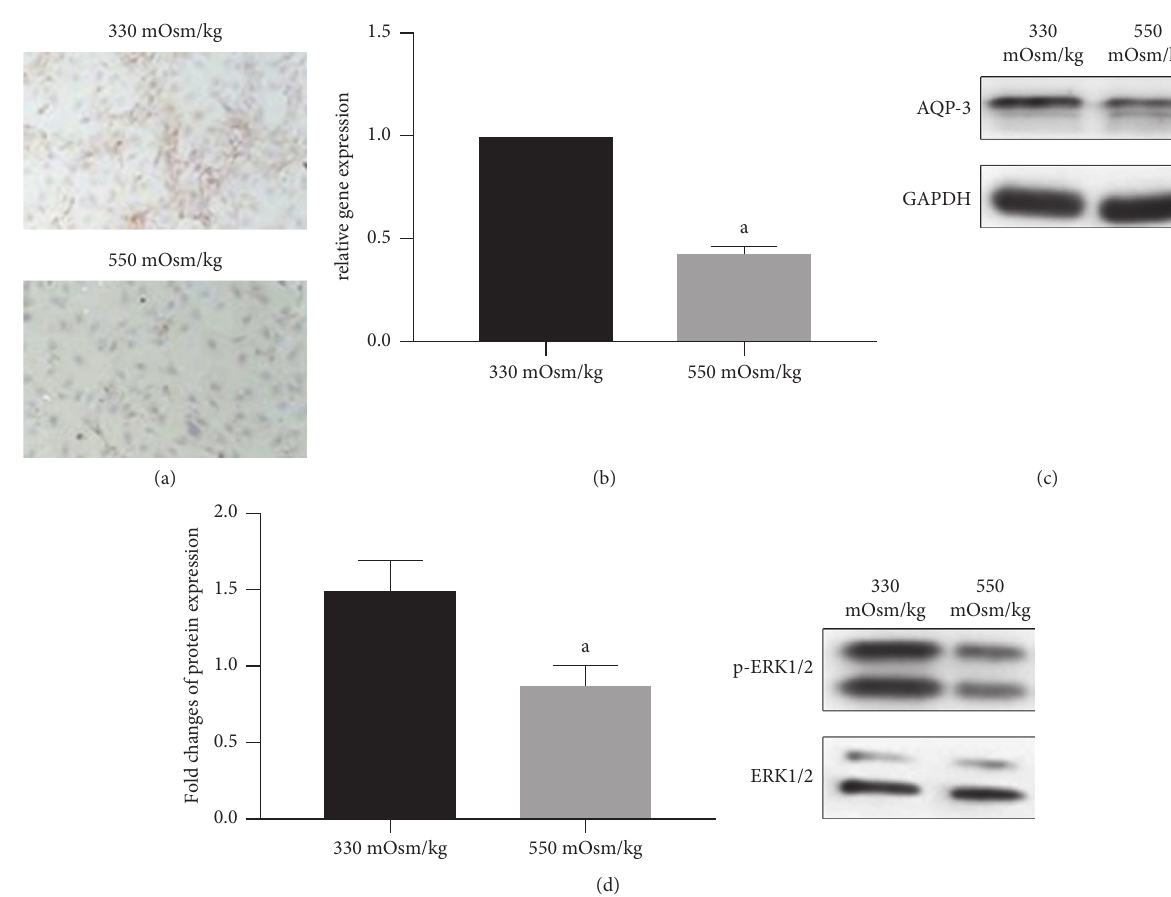
Figure 3: Hyperosmolarity decreased AQP-3 expression and inhibited activation of ERK1/2 signaling in NP cells. (a) Immunocytochemical detection of AQP-3 expression of NP cells under different osmotic pressures (330 mOsm/kg and 550mOsm/kg). (b, c) Real-time PCR and western blotting analysis of AQP3 expression under different osmolarity (330 mOsm/kg and 550mOsm/kg), respectively. (d) Western blotting analysis of ERK1/2 activation under different osmotic pressures (330 mOsm/kg and 550mOsm/kg). Data are expressed as mean ± SD. (A) indicates a significant difference ( p < 0 . 05) when compared with